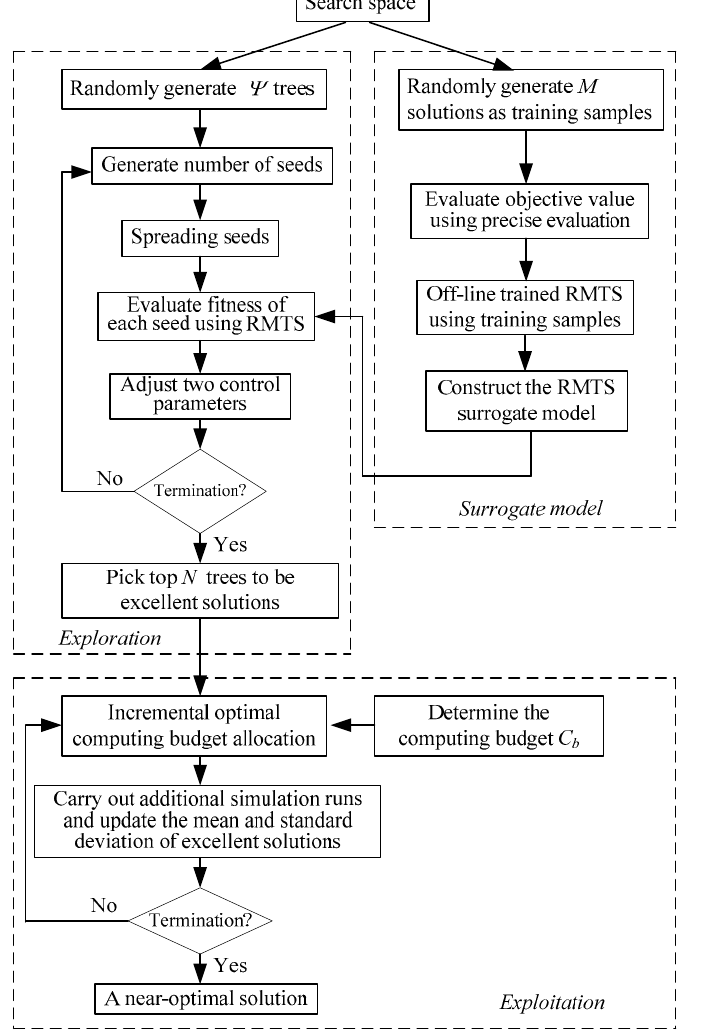
Figure 2. Flow chart of the proposed OOTSA approach.